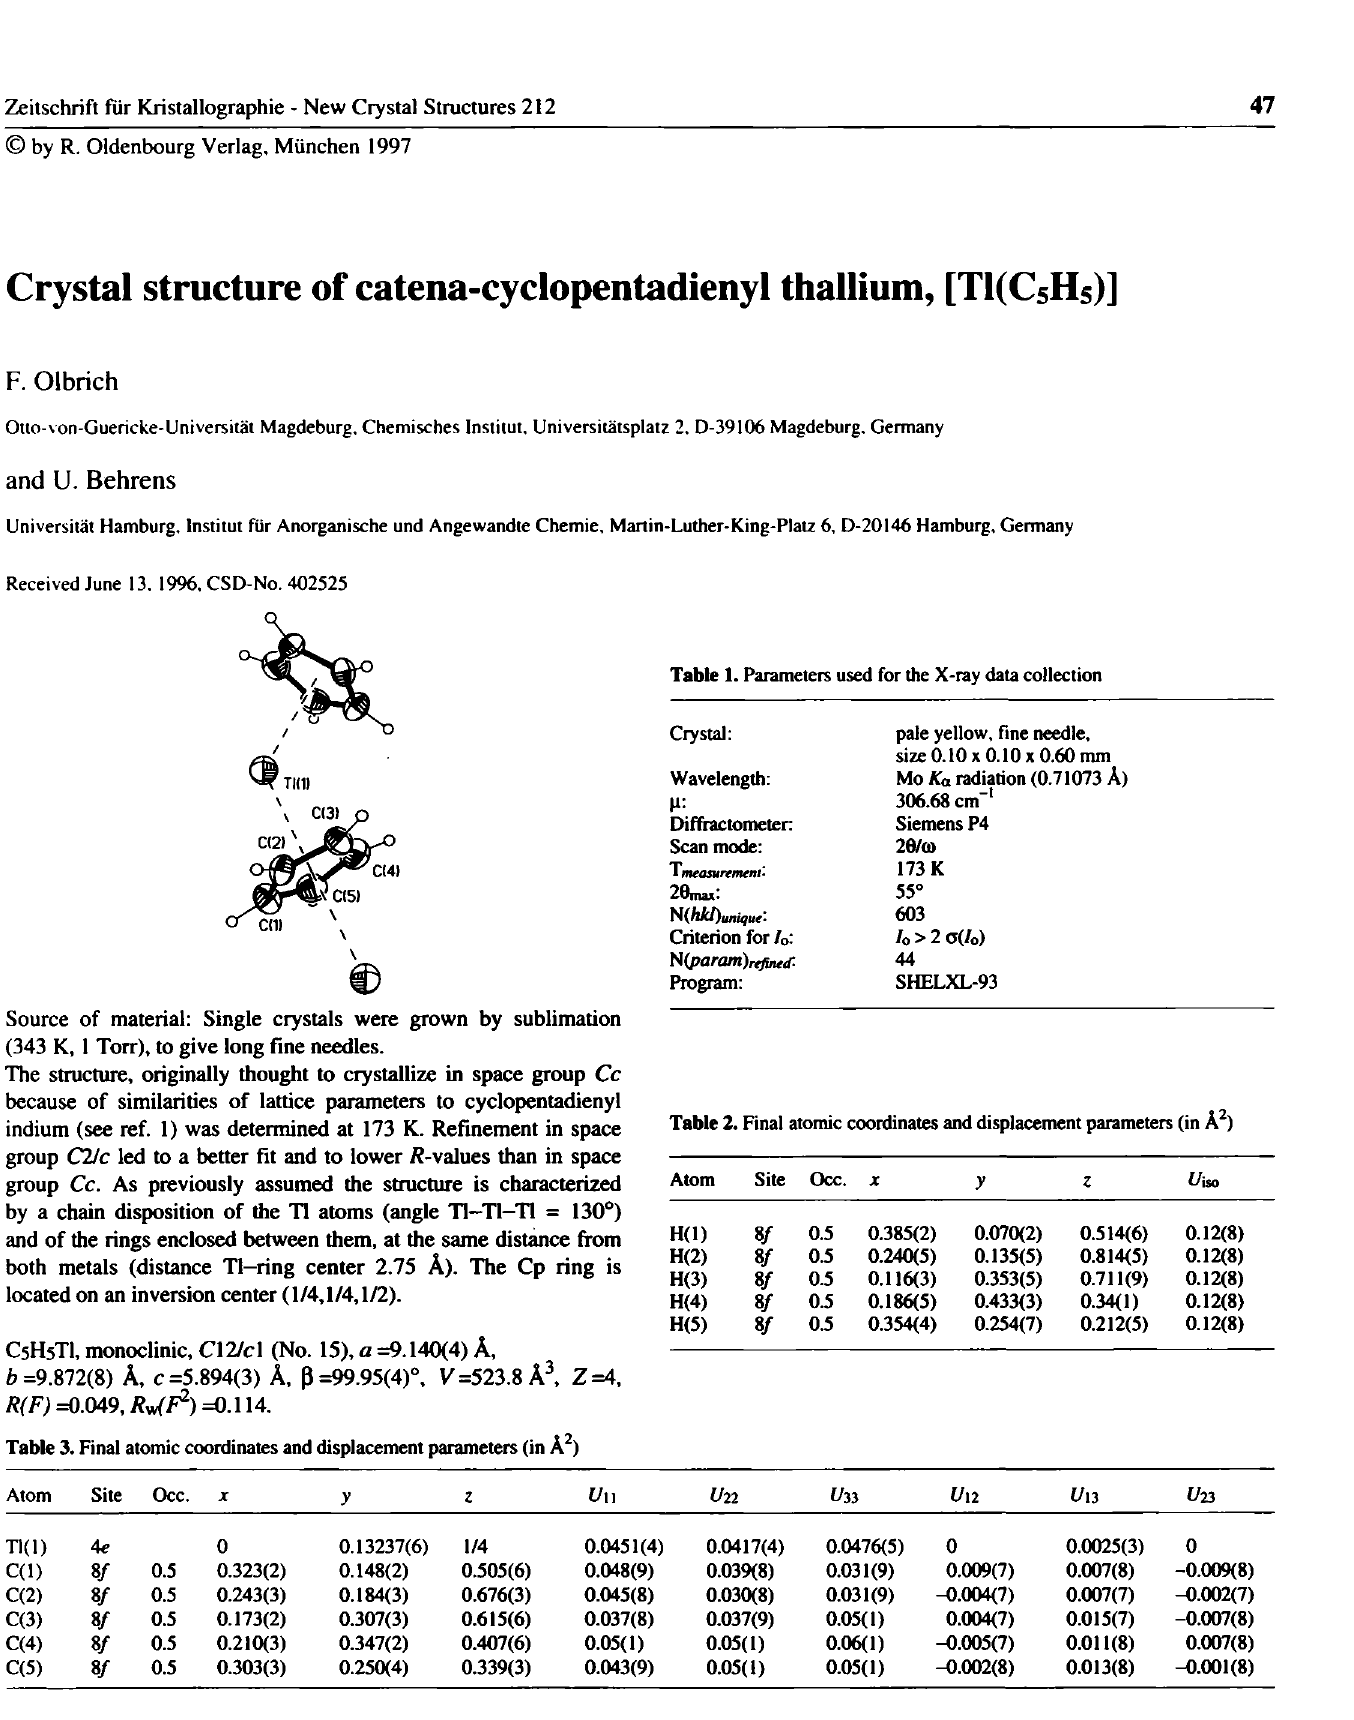
Table 3. Final atomic coordinates and displacement parameters (in Â 2 )